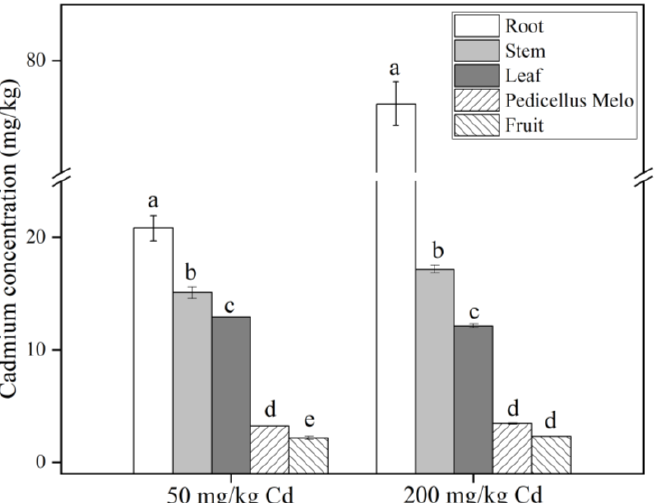
Figure 5. Cd content in roots, stems, leaves, muskmelon pedicel, and fruits of muskmelon plants under different Cd treatments. The data show the means ± SD of three replicates. The concentration of Cd was set to zero for the no Cd treatment, and different lowercase letters indicate significant differences at p < 0.05. Table 2. Health risk assessment of different parts treated with different concentrations of Cd. Each treatment was repeated three times, expressed as mean ± standard deviation. Each line of different letters represents significant differences at p < 0.05.